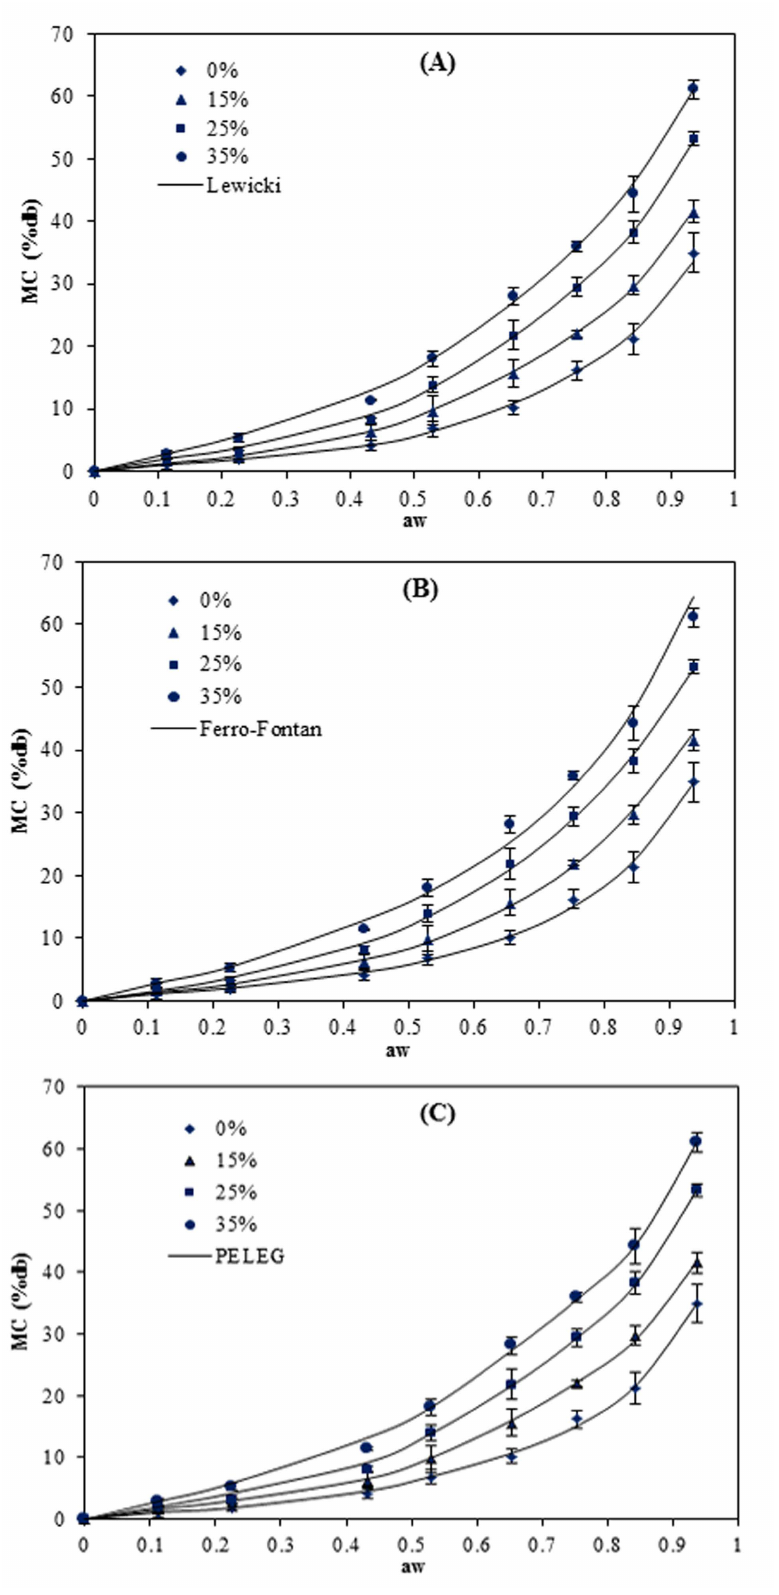
Figure 3. Equilibrium moisture sorption isotherm of pea starch film with different glycerol content ( w / w ) at 25 ˝ C. The symbols are experimental data and the lines are from the equations obtained by fitting the experimental data to Lewicki ( A ), Ferro–Fontan ( B ) and PELEG ( C )